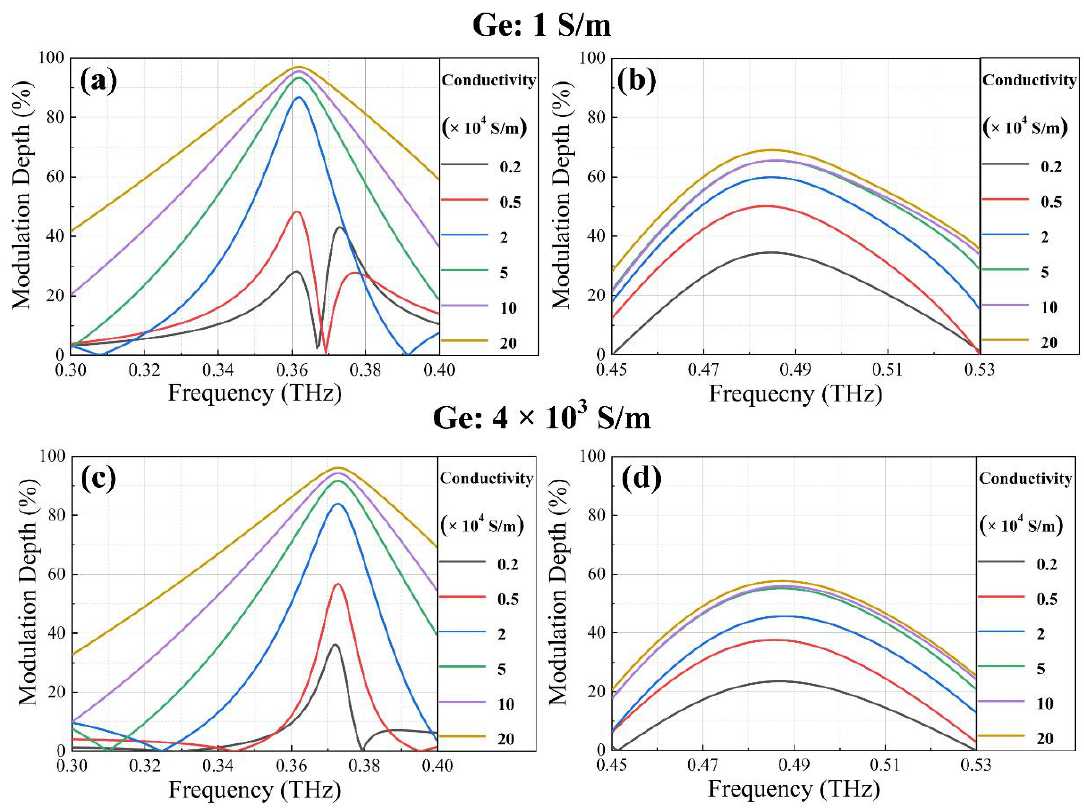
Figure 4. MD for varying VO 2 conductivity with and without optical pump irradiation. ( a , b ) MD depending on the conductivity of VO 2 bridges at 0.30–0.40 THz and 0.45–0.53 THz when the conduc- tivity of Ge layers is 1 S/m. ( c , d ) MD depending on the conductivity of VO 2 bridges at 0.30–0.40 THz and 0.45–0.53 THz when the conductivity of Ge layers is 4 × 10 3 S/m.